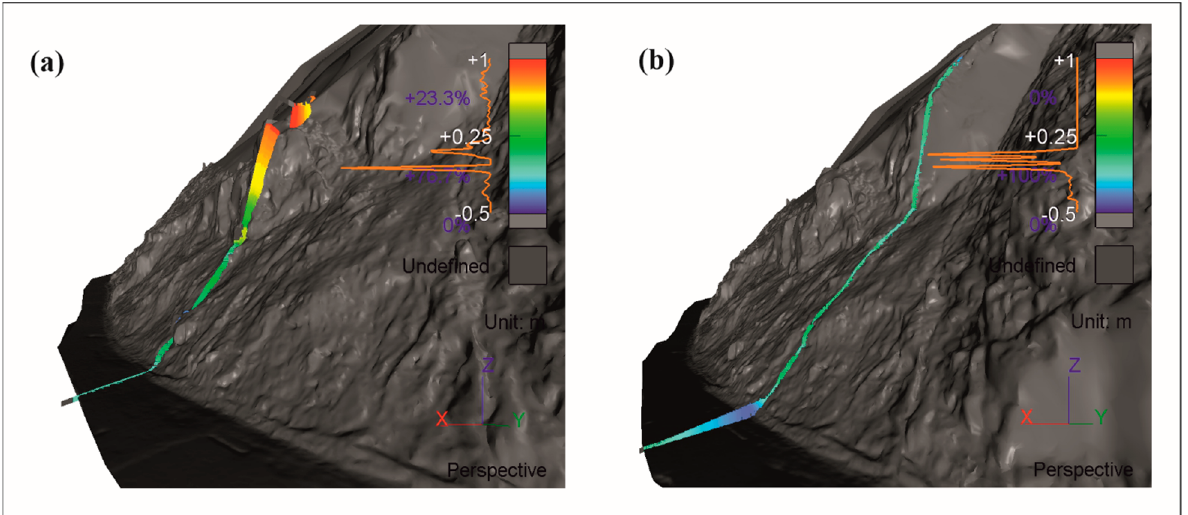
Figure 13. ( a ) Deviation between the surface sections of TLS point clouds acquired on 10 June 2020 and 25 September 2020. ( b ) Deviation between the surface sections of TLS point clouds, acquired on 25 September 2020 and 7 November 2021.